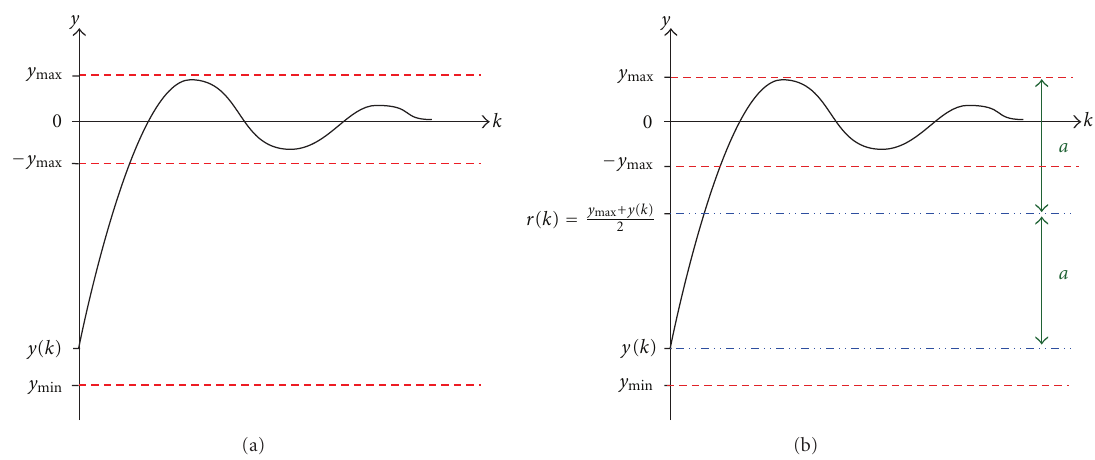
Figure 1: (a) Illustration of the more conservative constraint (14) in case (i). (b) Heuristic solution proposed by Cavalca et al. [4].